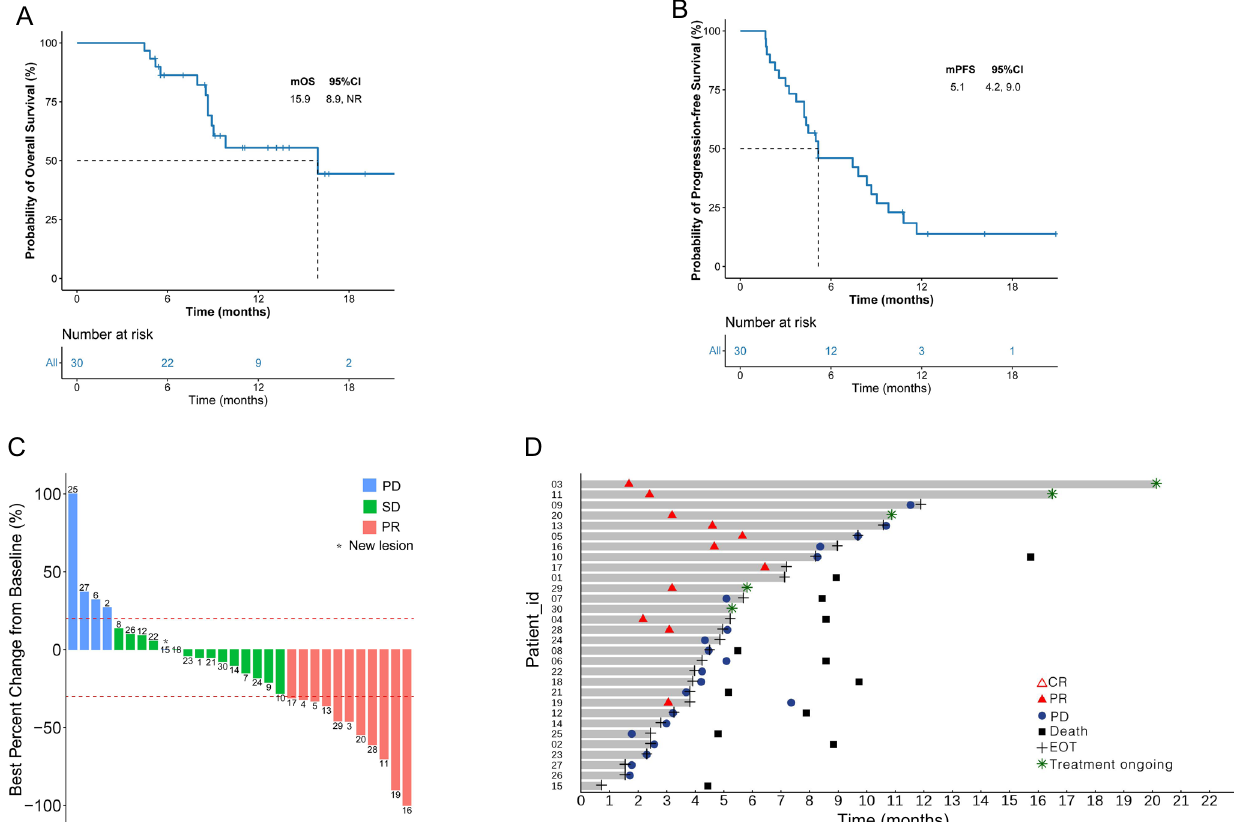
Fig. 2 | Kaplan-Meier curves and characteristics of objective response in the study. A Kaplan-Meier estimates of overall survival ( n =30). B Kaplan-Meier esti- matesofprogression-freesurvivalbyRECISTv1.1( n =30). C Changeoftargetlesion in tumor size from baseline to best response ( n =30). D Swimming chart showing